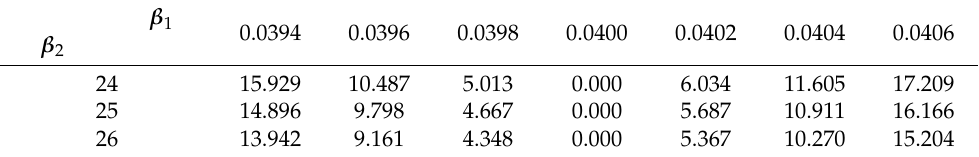
 (%). Amplitudes  ,  were used to identify the nonsymmetric kernel, Table 1. Error values 1 1 2 K . 12 Table 1. Error values ε 1 (%). Amplitudes β 1 , β 2 were used to identify the nonsymmetric kernel, K 12 .